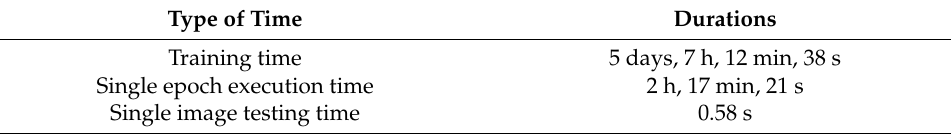
Table 7. Processing time details for the IR-v2 Type 5 model.